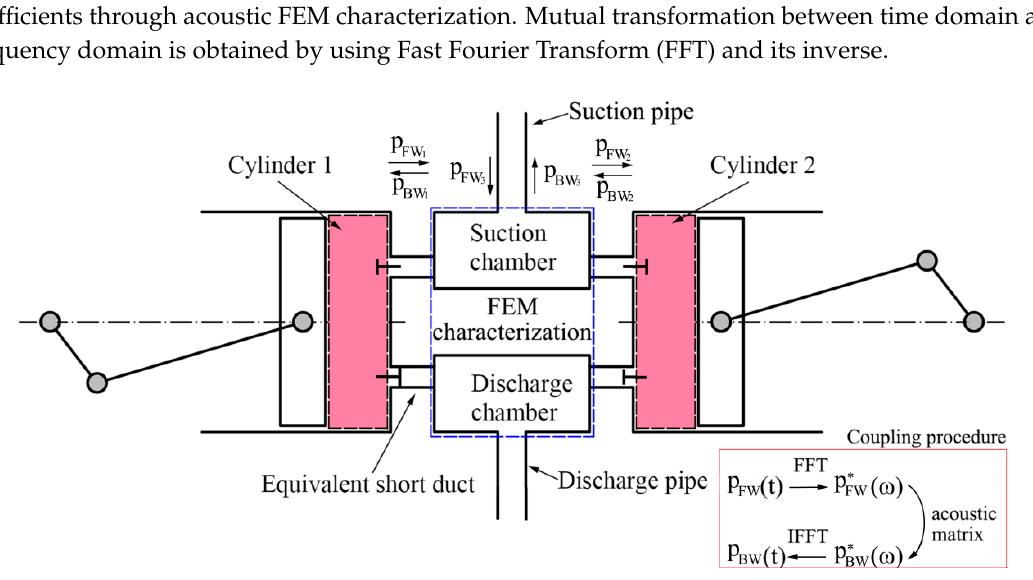
Figure 3. Schematic description of the compressor hybrid model.